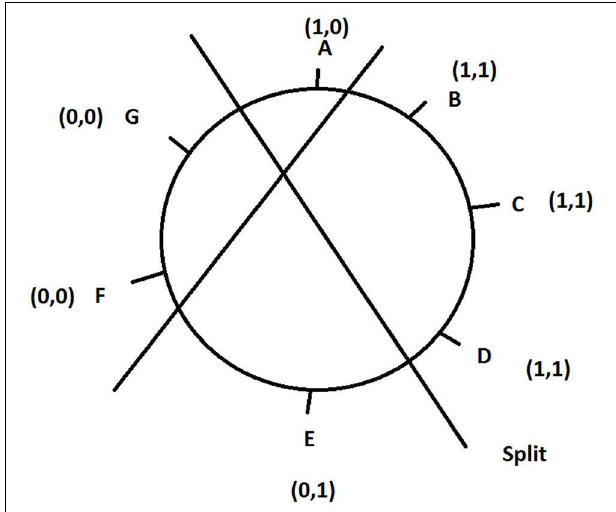
FIGURE 6 | A circular order for objects A–G, with their pairs of binary states, arranged according to the circular consecutive-ones condition. The two lines show two different split, one between (0, * ) and (1, * ), the other one between ( * ,0) and ( * ,1).